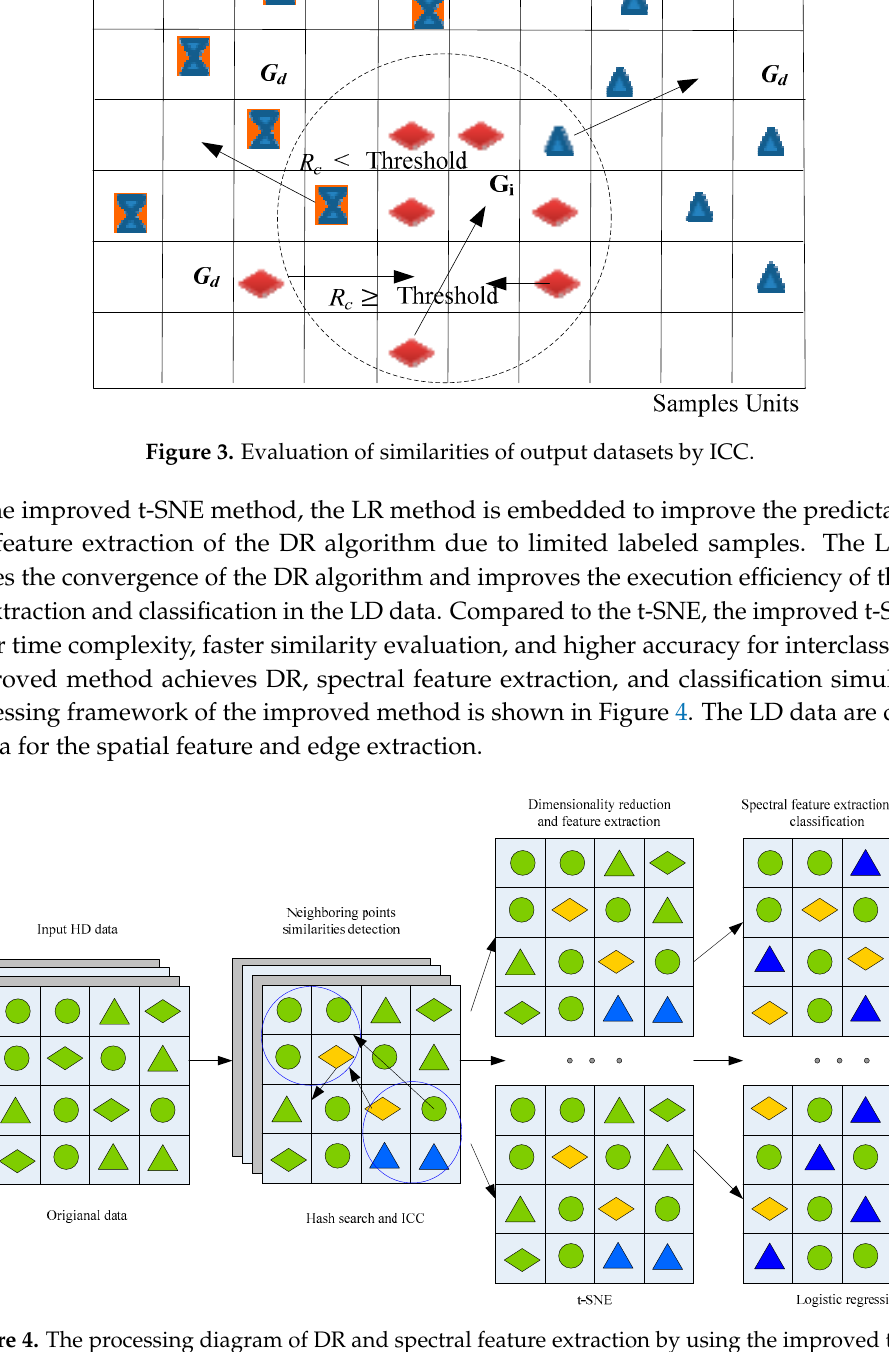
Figure 4. The processing diagram of DR and spectral feature extraction by using the improved t-SNE.